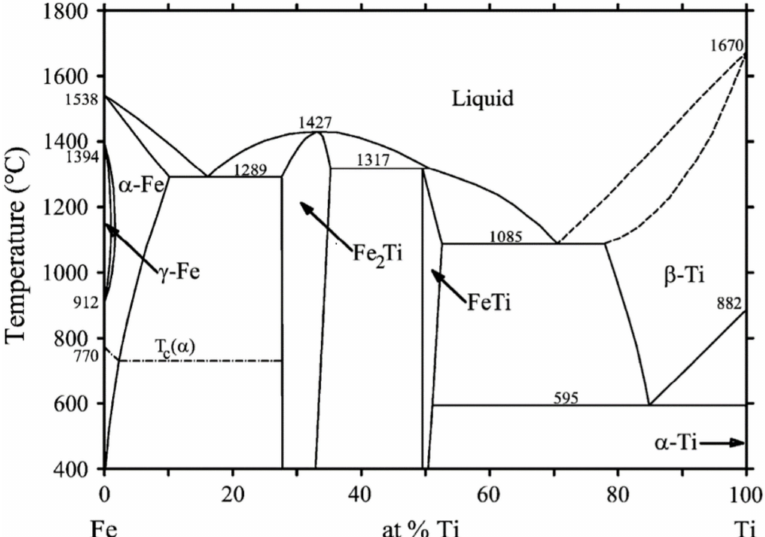
Figure 1. The phase diagram of Fe-Ti [13].